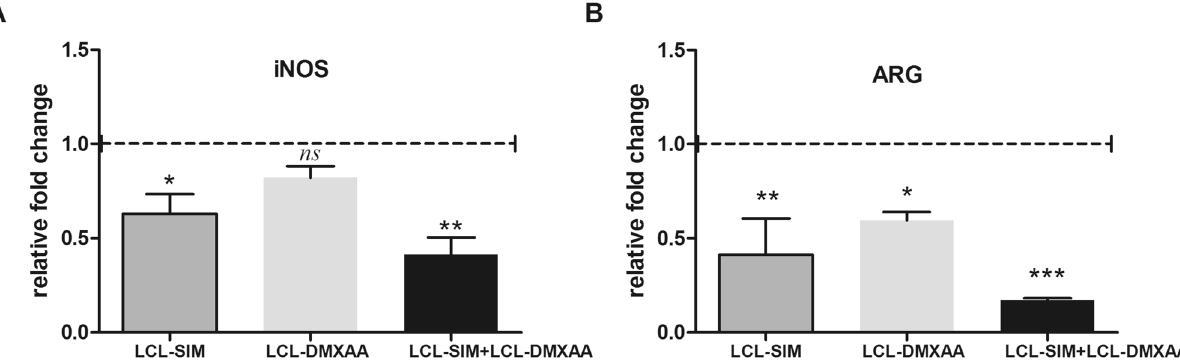
Figure 2. Effects of LCL-SIM and LCL-DMXAA single and combined treatment on the mRNA expression levels of enzymes involved in arginine metabolism in TME. ( A ), ( B ) Effects of liposomal SIM and DMXAA administration on the expression levels of iNOS and ARG-1. mRNA was quantified by RT-qPCR and the results were expressed as fold change based on the Ct calculations. Control—LCL-treated group was used as calibrator. Results were expressed as mean ± SD of three independent measurements. Control—LCL-treated group; LCL-SIM—experimental group treated with 5 mg/kg SIM as liposome-encapsulated form; LCL-DMXAA— experimental group treated with 14 mg/kg DMXAA as liposome-encapsulated form; LCL-SIM + LCL- DMXAA—experimental group treated with 5 mg/kg SIM and 14 mg/kg DMXAA as liposome-encapsulated forms. ( ns , P > 0.05; *, P < 0.05; **, P < 0.01; ***, P < 0.001). The graphs were generated using GraphPad Prism 9.2.0.332 (Serial number: GPS-2216002-E###-#####, MachineID: 3383874FBDD) (https:// www. graph pad.